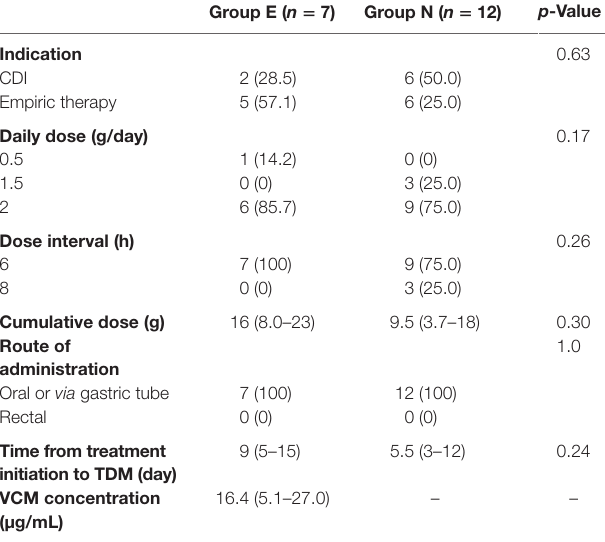
Table 2 | VCM treatment and serum VCM concentration.